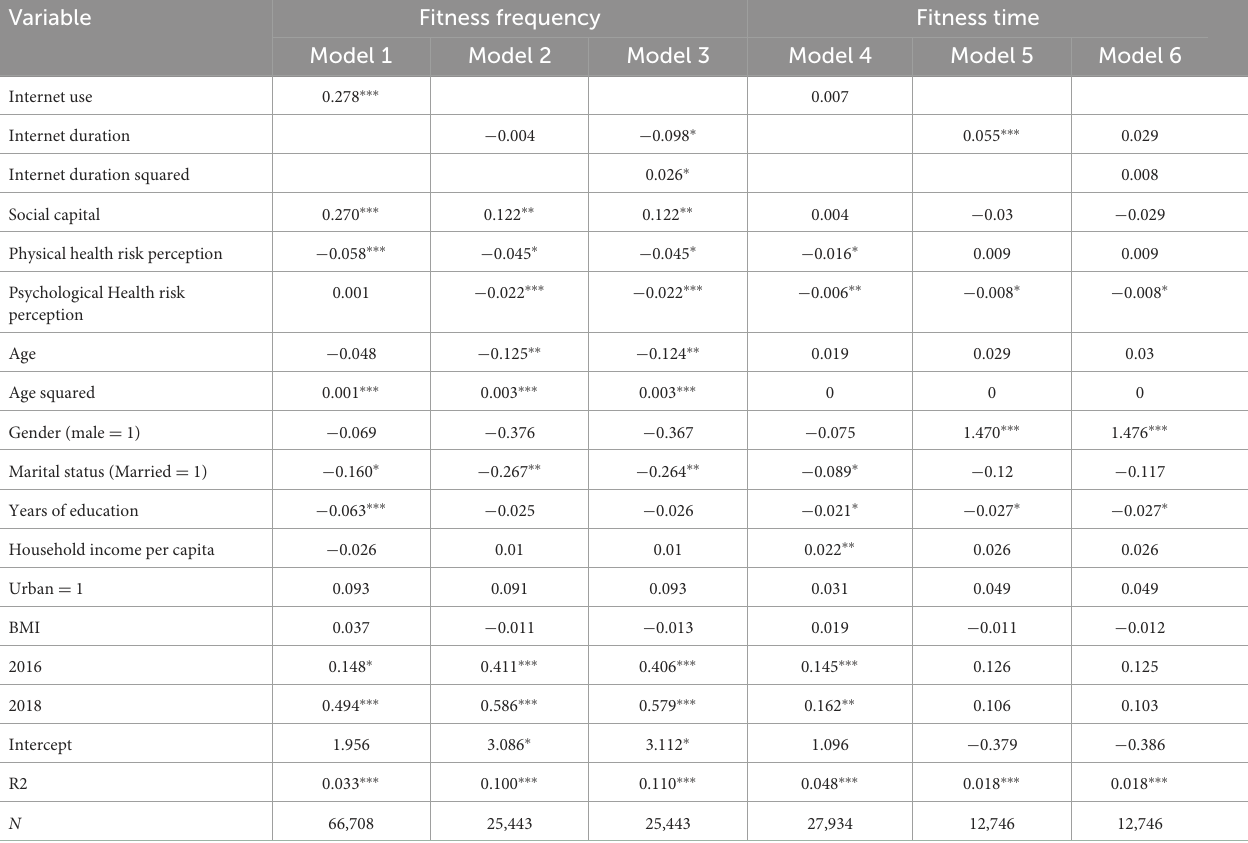
TABLE 2 The influence of Internet on the frequency and time of residents’ physical fitness.